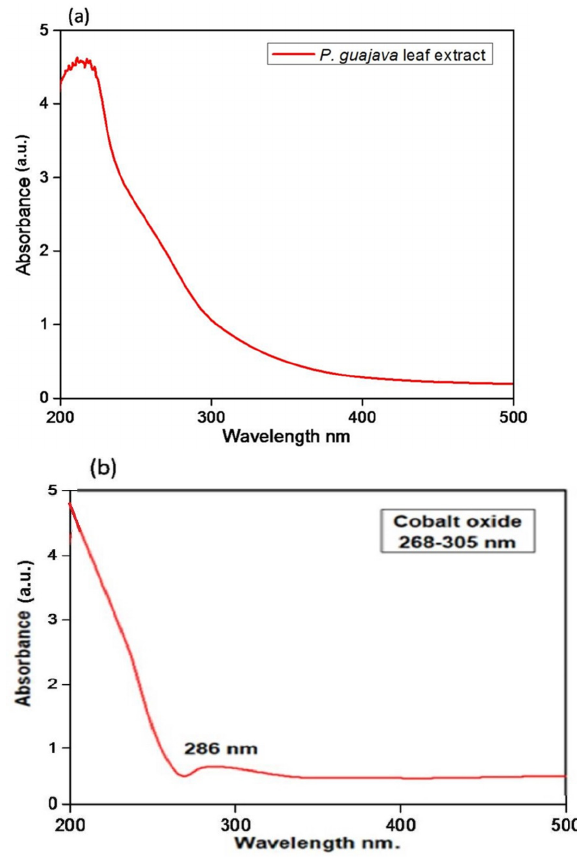
Figure 1. ( a ) UV–Visible spectrum of Psidium guajava leaf extract and ( b ) Green synthesized P. guajava Co 3 O 4